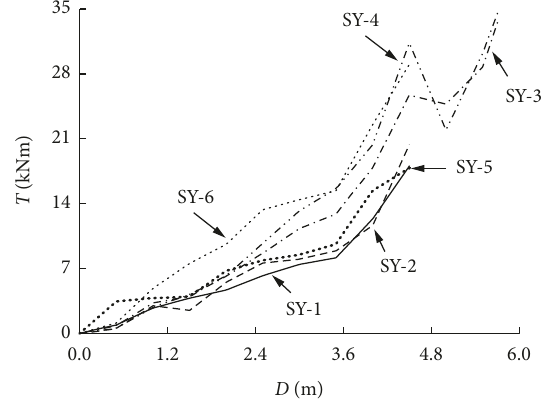
Figure 4: Torque-depth curve of screw